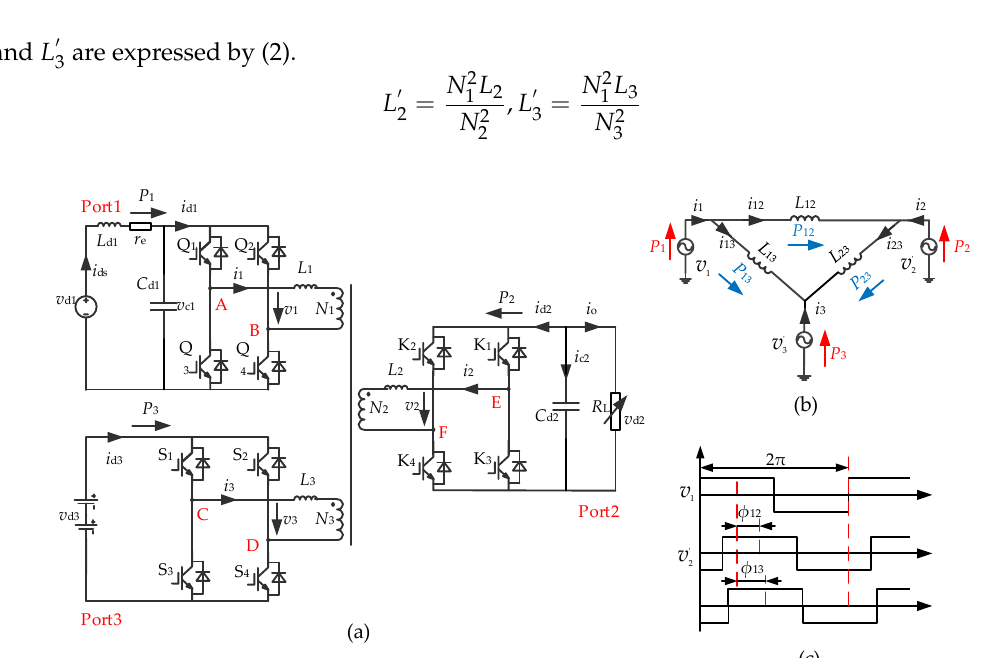
Figure 1. The isolated three-port converter: ( a ) topology; ( b ) equivalent Δ-connected circuit; ( c ) modulation scheme.